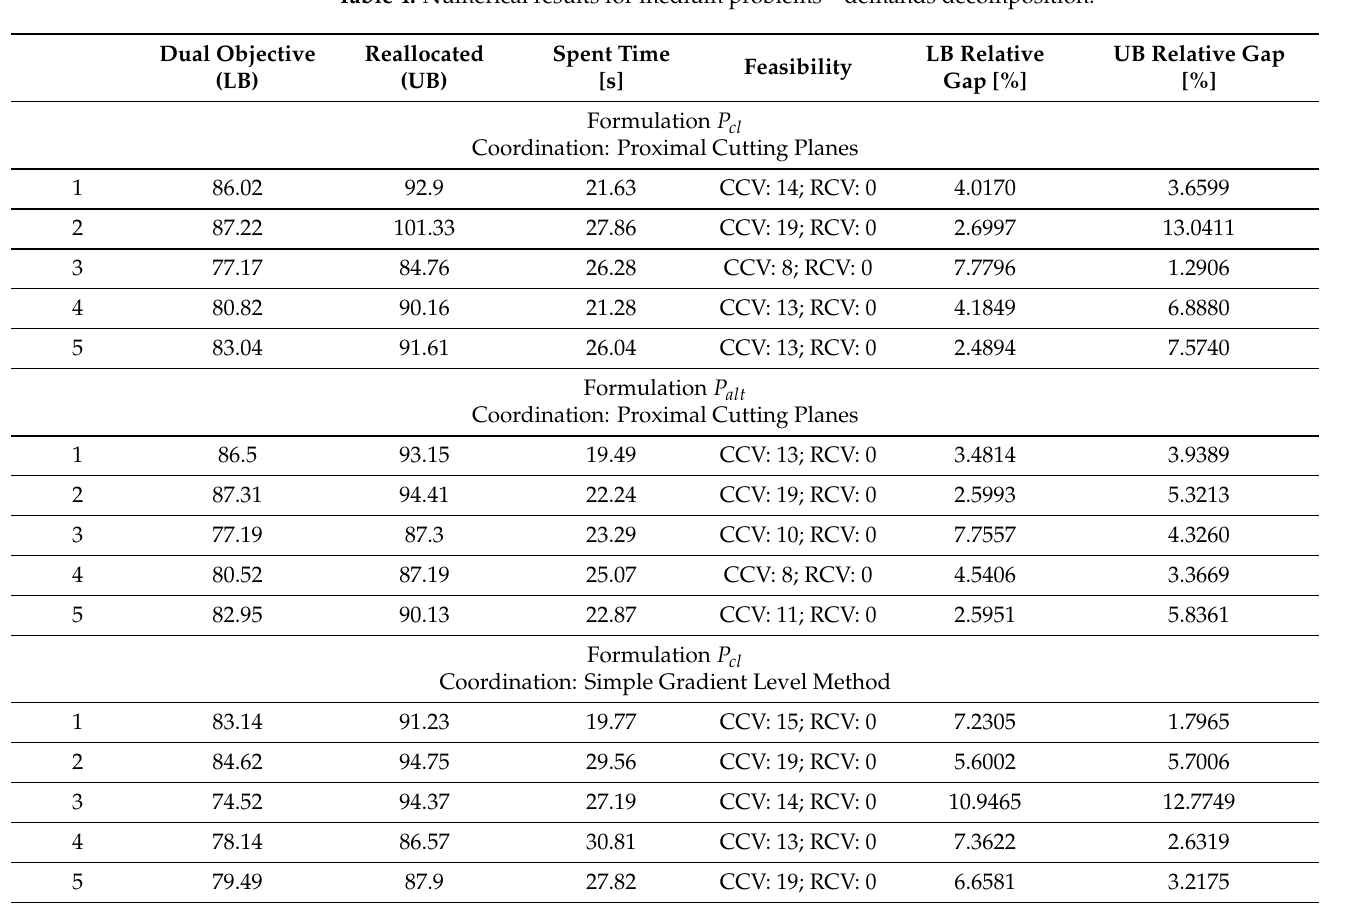
Table 4. Numerical results for medium problems—demands